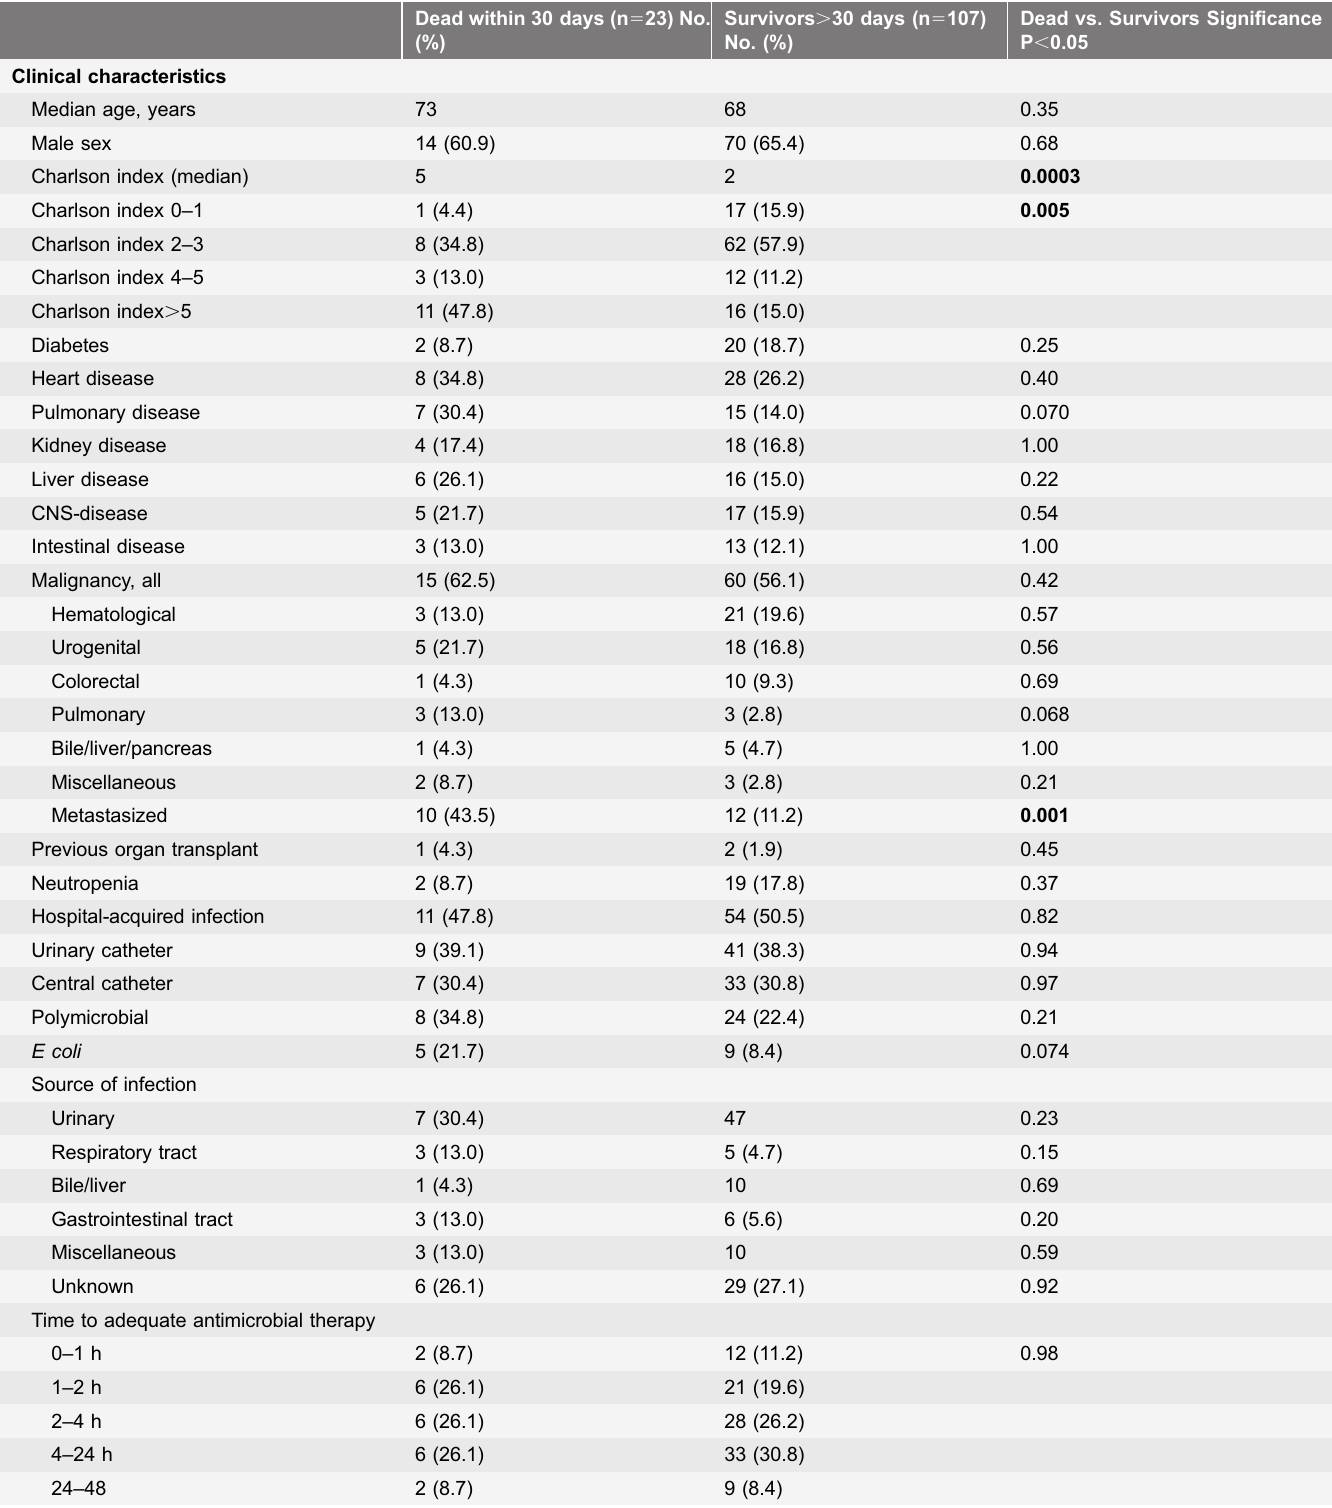
Table 3. Comparison between patients with 30-day mortality and